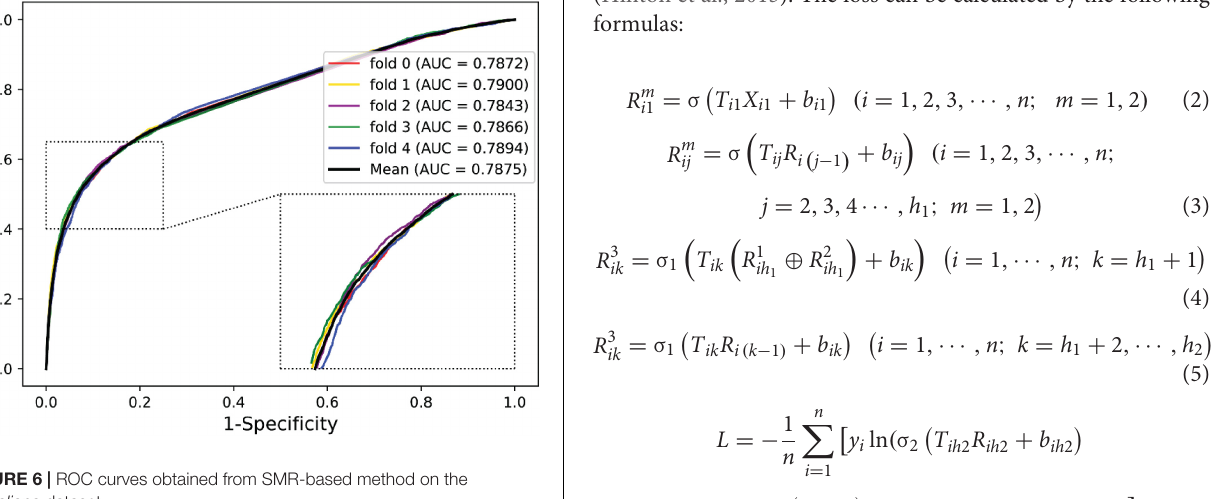
FIGURE 6 | ROC curves obtained from SMR-based method on the A. thaliana dataset.